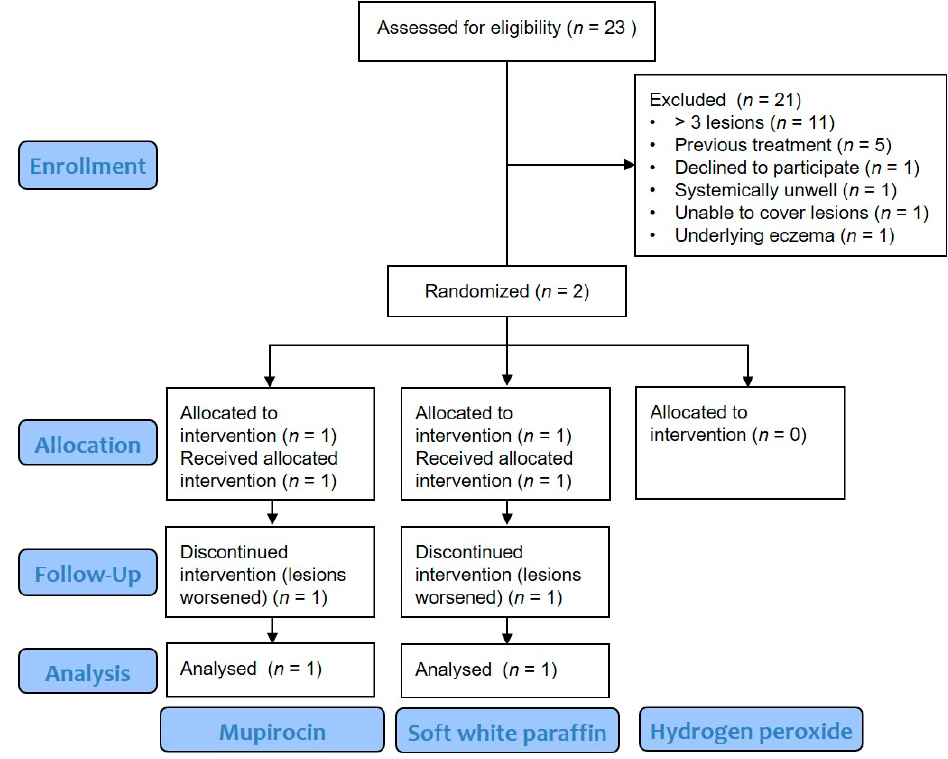
Figure 1. Consort flow diagram outlining treatment group pathways .